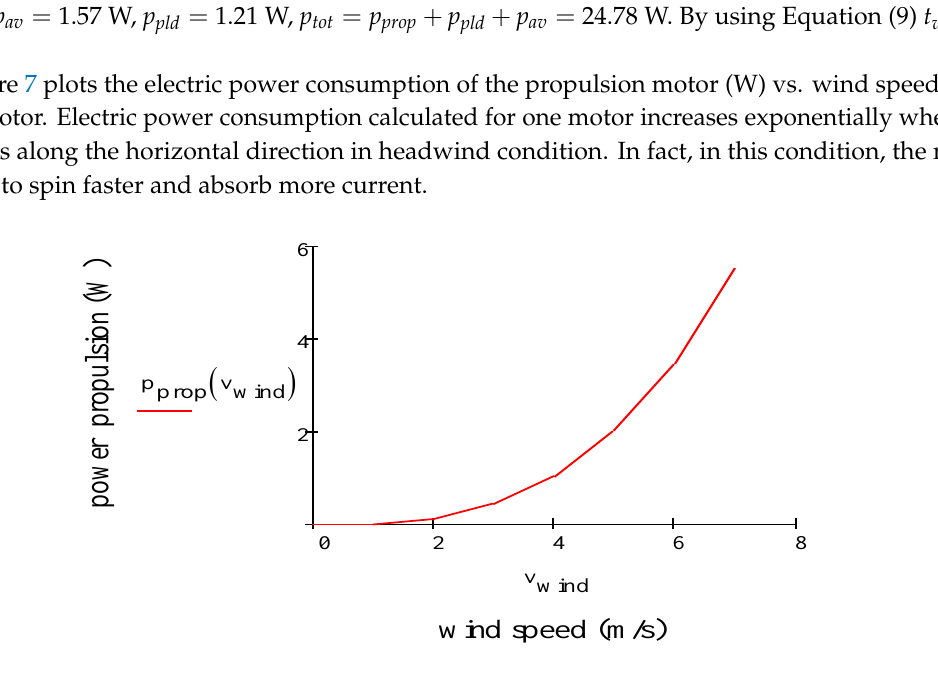
Figure 6. Travel distance as a function of motor efficiency and cruising velocity.